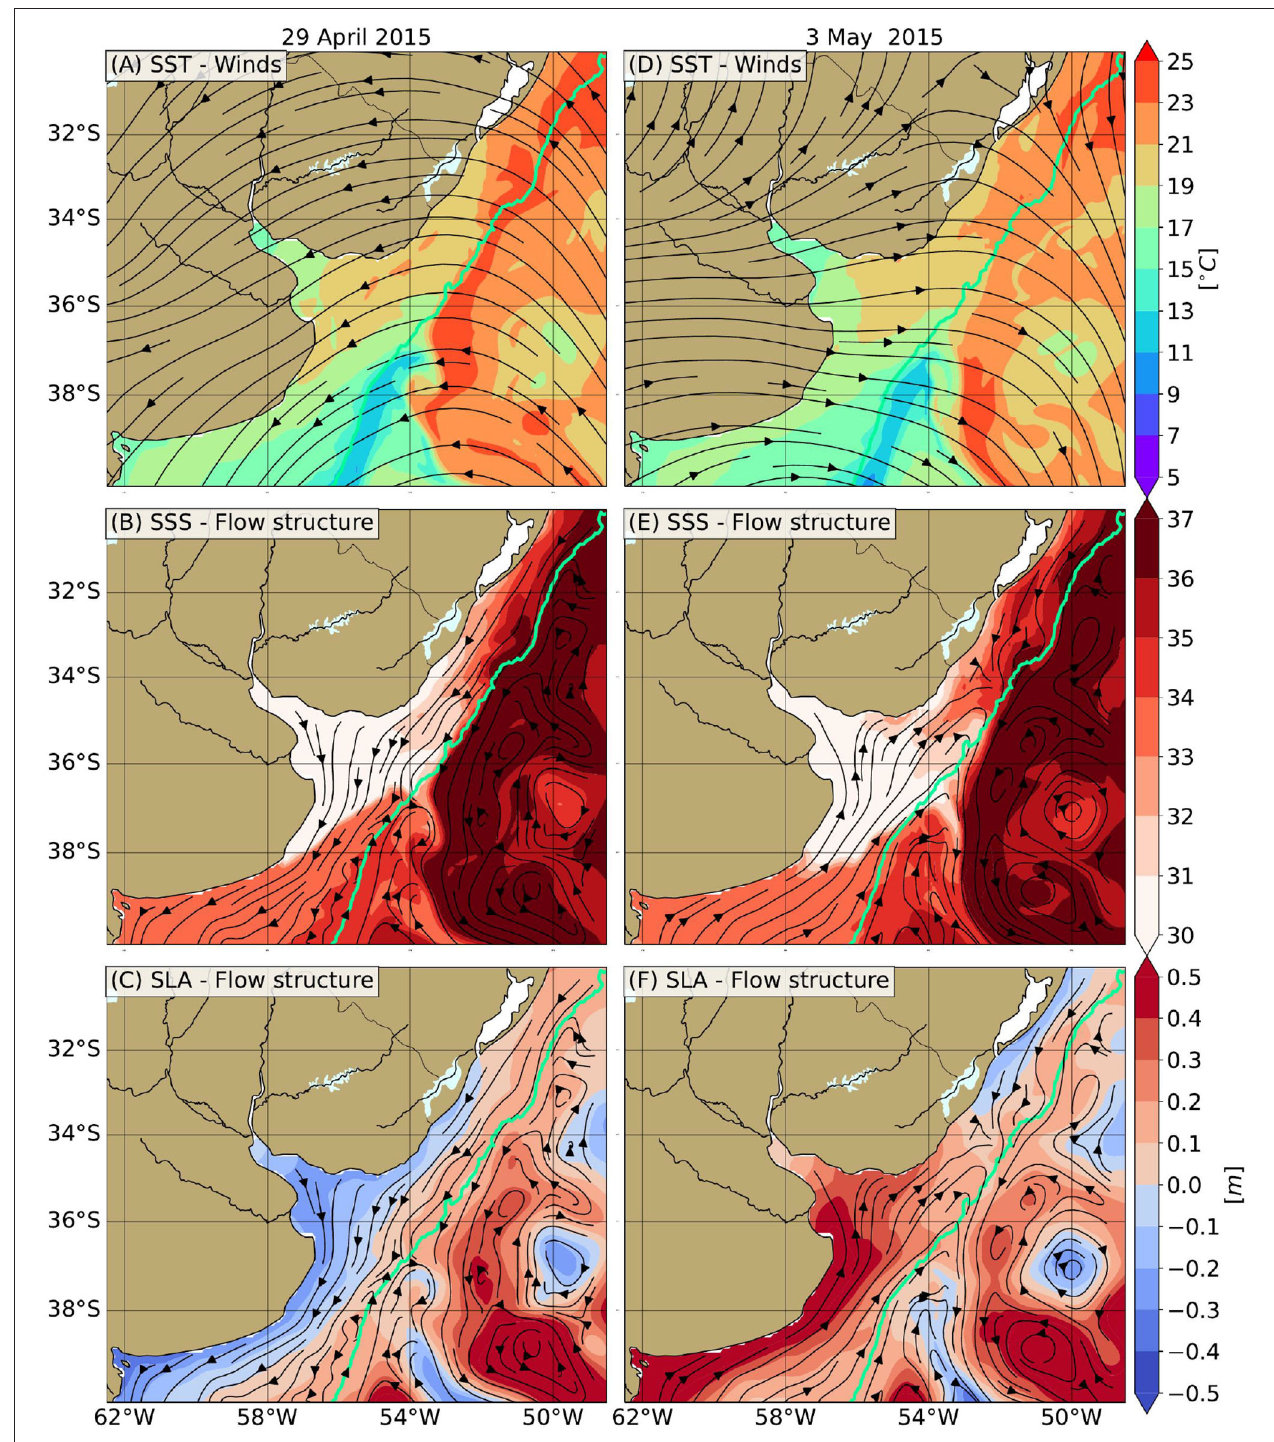
FIGURE 11 | SST ( ◦ C, A,D ), SSS (B,E) , SLA (m, C,F ) are shown in colors (color scale at right). Black streamlines show the flow structure over the upper 200 m (B,C,E,F) and surface wind patterns from ERA5 (A,D) . The left panels (A–C) present the fields on 29 April 2015 and the right panels (D–F) on 3 May 2015. The 200 m isobath is indicated by a green